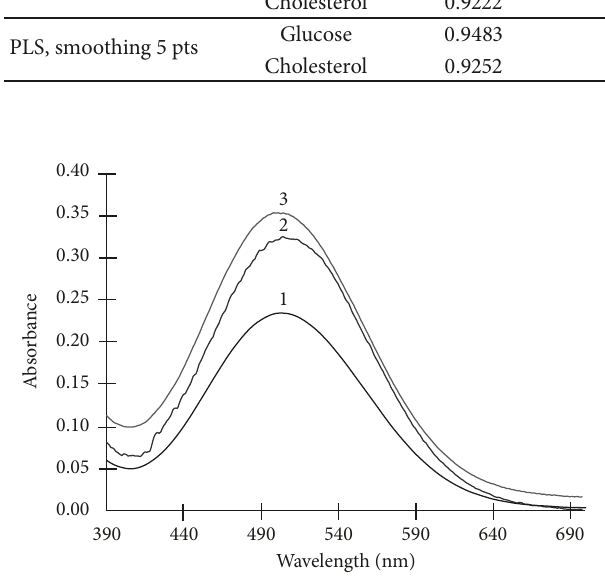
Figure 2: UV-Vis spectra of (1) mixture of glucose (0.6 mg/dL) and cholesterol(0.6 mg/dL), (2) 2.5 mg/dL of glucose,and (3) 2.5 mg/ dL of